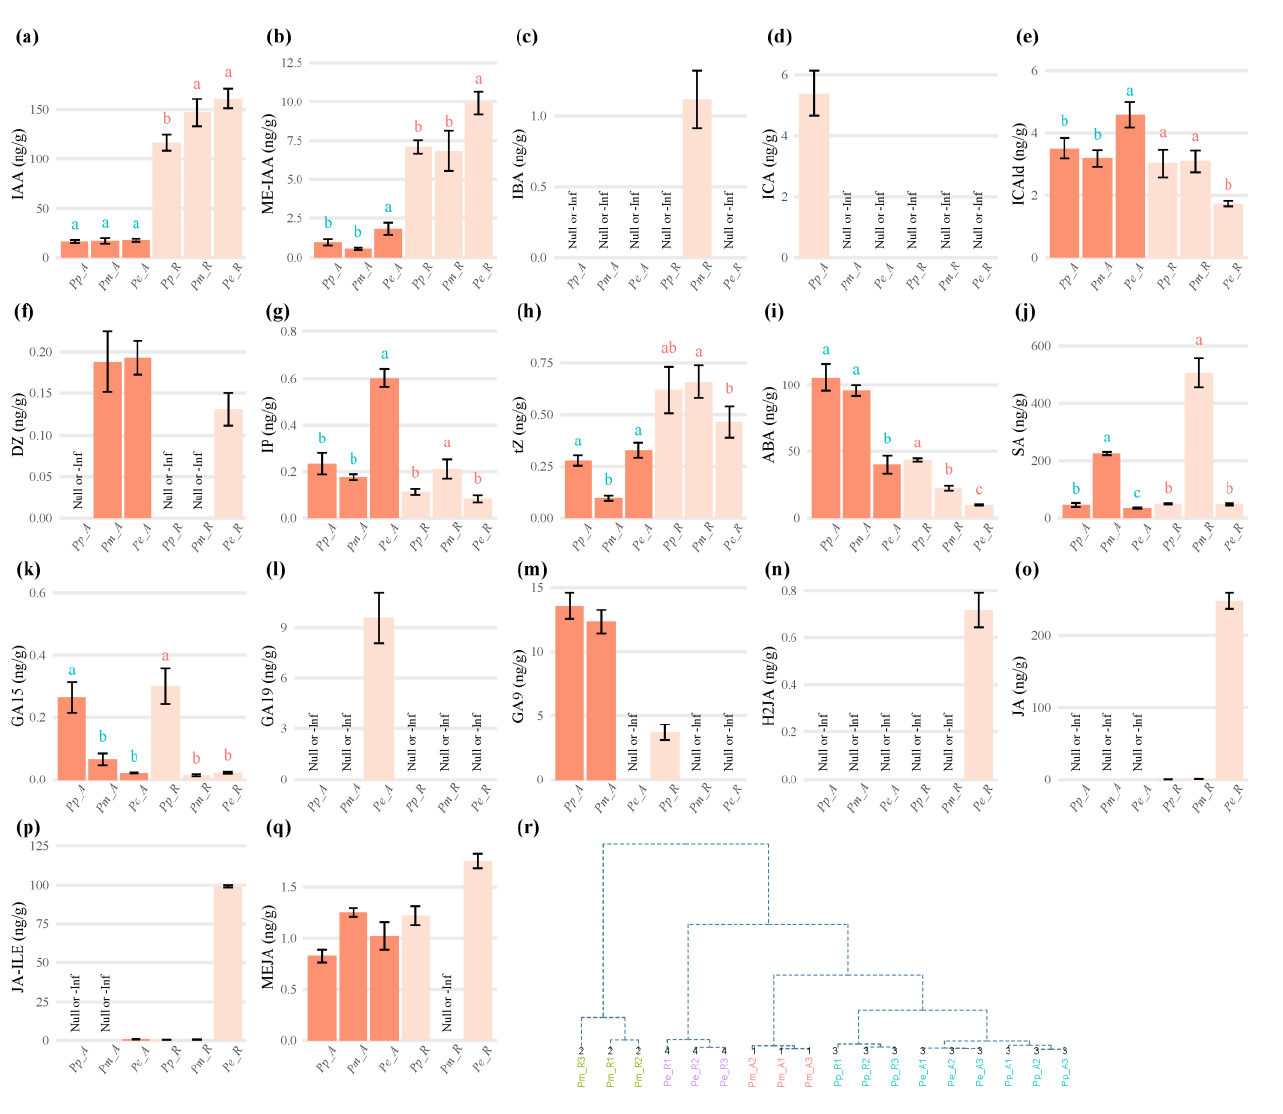
Figure 1. Determination of endogenous phytohormone contents in three pine species. In ( a – q ), they were histogram of IAA, ME-IAA, IBA, ICA, ICAld, DZ, IP, tz, ABA, SA, GA 15 , GA 19 , GA 9 , H 2 JA, JA, JA-lie, MeJA respectively. ( r ) The cluster analysis of endogenous phytohormone contents. Note: In ( a – q ), error bars represented means ± SD (n = 3). Multiple comparative analysis was performed using LSD.test analysis, different label with colors represented the results of one-way ANOVA of different parts, the group with no signal was marked as “Null or -Inf”. Pm , Pinus massoniana ; Pp , Pinus yunnanensis var. pygmaea ; Pe , Pinus elliottii ; A, shoot apical meristem; R, root apical meristem; In ( r ), the method adopted was hclust cluster, the number of clusters was 4.